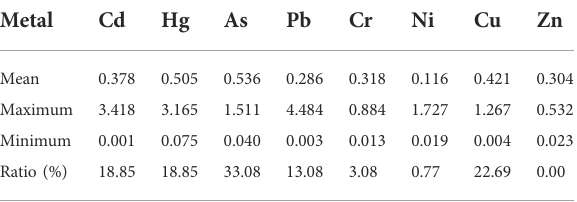
TABLE 5 Single factor pollution index of heavy metals in